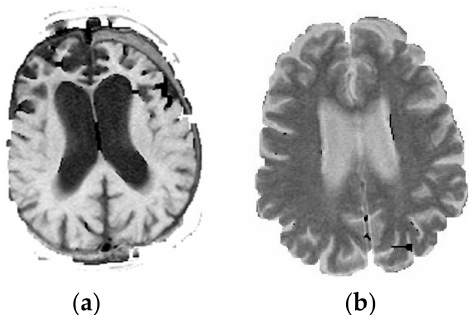
Figure 2. ( a ) The T1 brain region of interest (ROI); ( b ) The T2 brain region of interest (ROI).